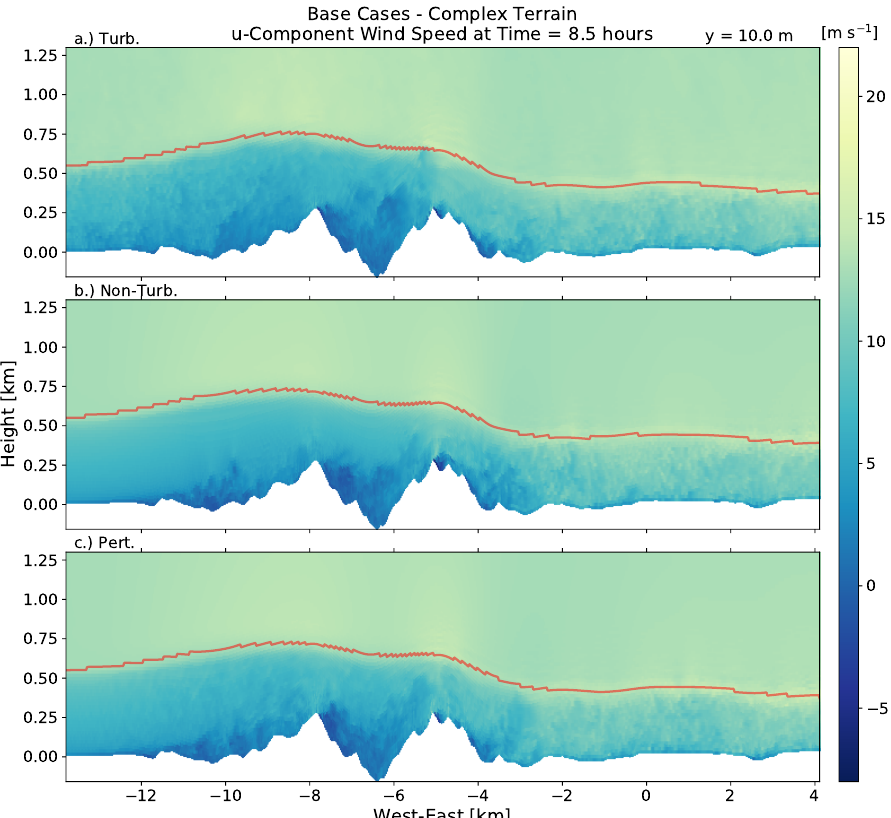
Figure 8. Vertical cross sections of u -component wind speed along the slice, y = 10.0 m for the ( a ) Turbulent, ( b ) non-turbulent, and ( c ) cell perturbation simulations in the CXT_base cases. The red line indicates the height of the boundary layer based on the temperature profile at each